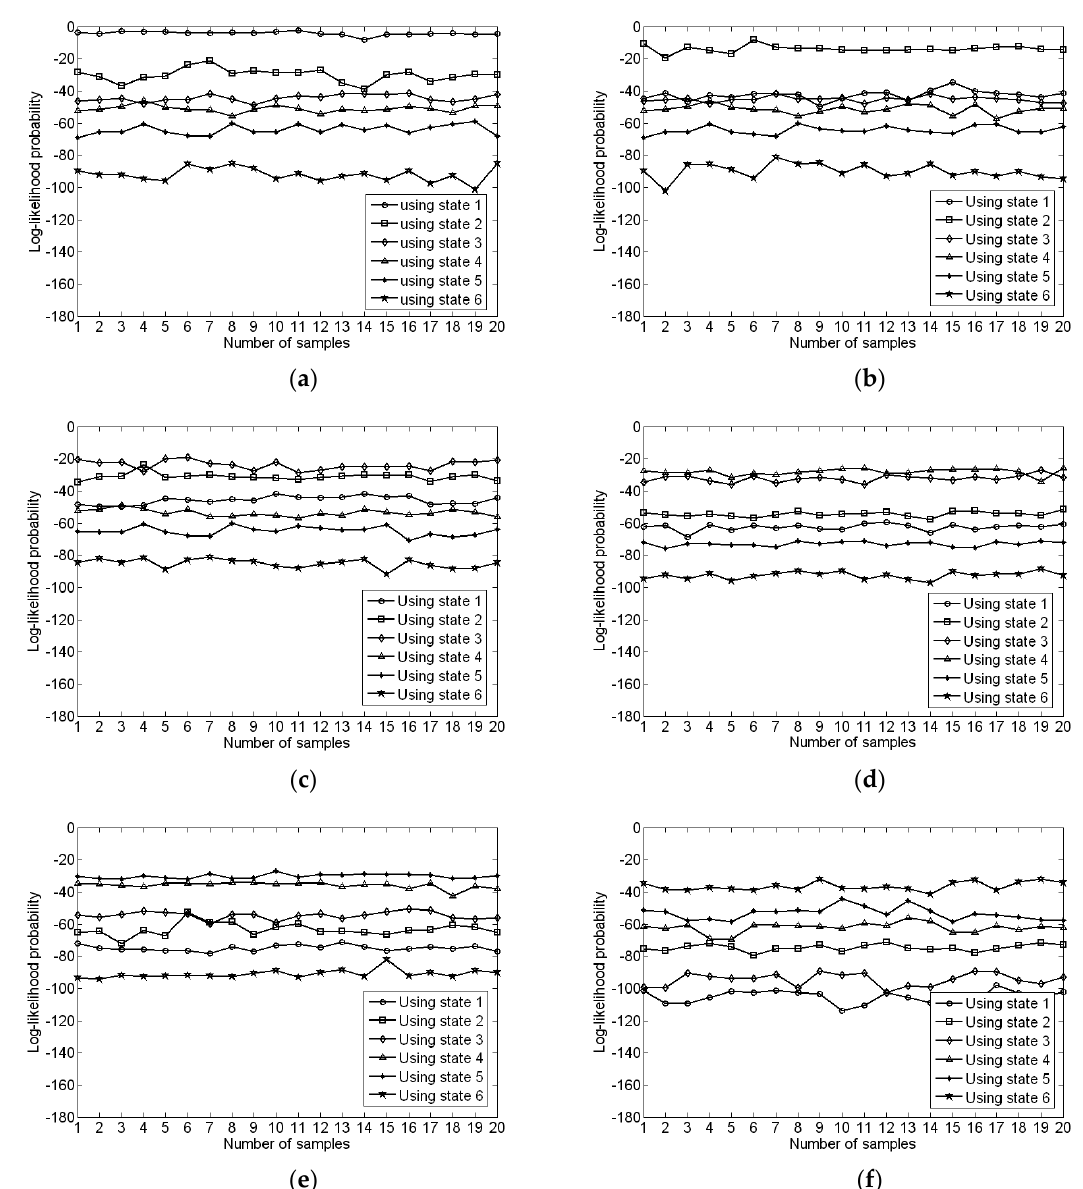
Figure 11. Evaluation results. ( a ) Evaluation results of the using state 1; ( b ) Evaluation results of the using state 2; ( c ) Evaluation results of the using state 3; ( d ) Evaluation results of the using state 4; ( e ) Evaluation results of the using state 5; ( f ) Evaluation results of the using state 6.